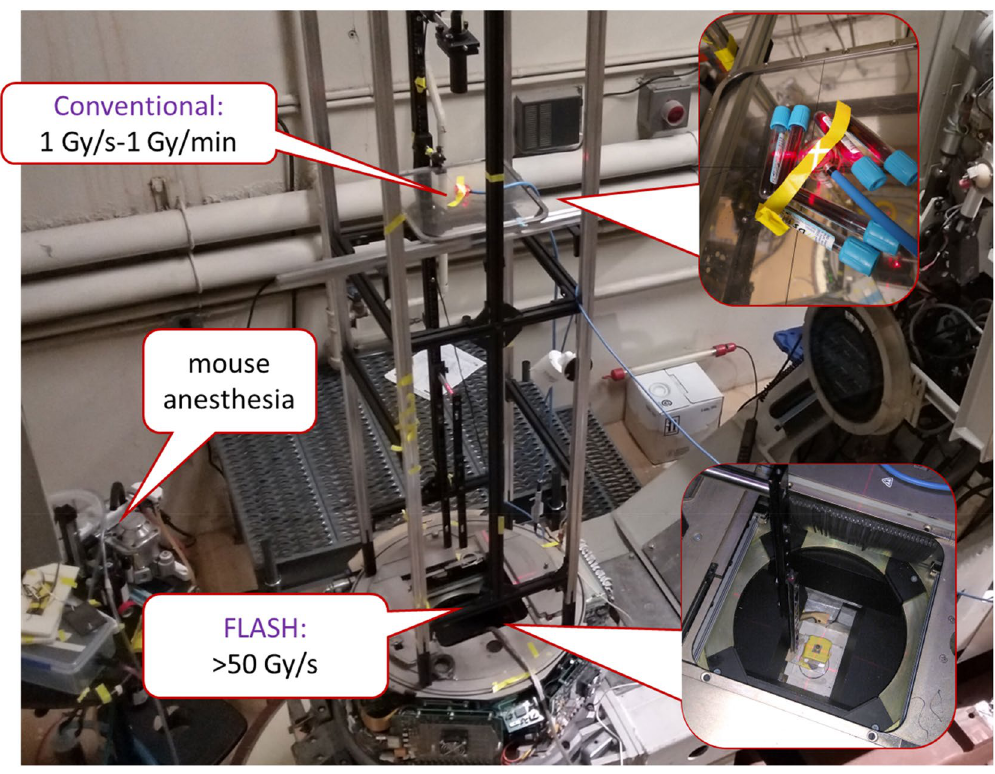
Figure 1. Photo of the ultra-high dose rate